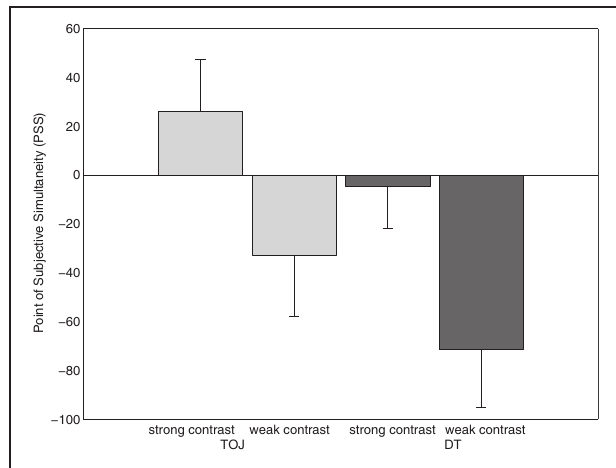
FIGURE 2 | Points of subjective simultaneity (PSS) for the two task conditions temporal-order judgment (TOJ) and dual task (DT) in Experiment 1, each measured in two contrast conditions, strong and weak